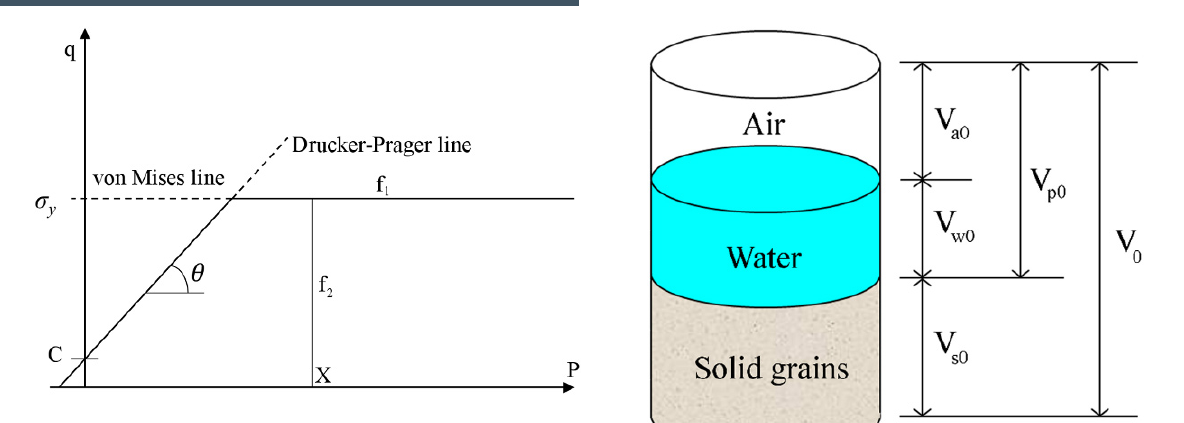
Figure 2. The constitutive soil model, f 1 is the failure envelope and f 2 is the moving strain hardening cap. The cap position X , the von Mises yield stress σ y , the internal friction angle θ and the cohesion C is shown. Figure 3. Definition of initial volumes of a soil sample.